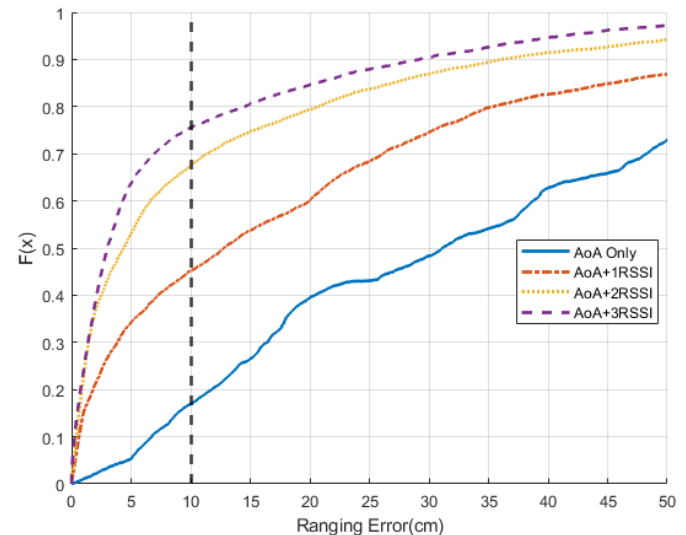
Figure 5. Error comparison between